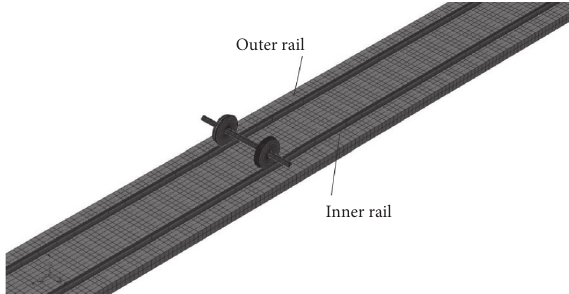
Figure 15: Wheelset-track coupled